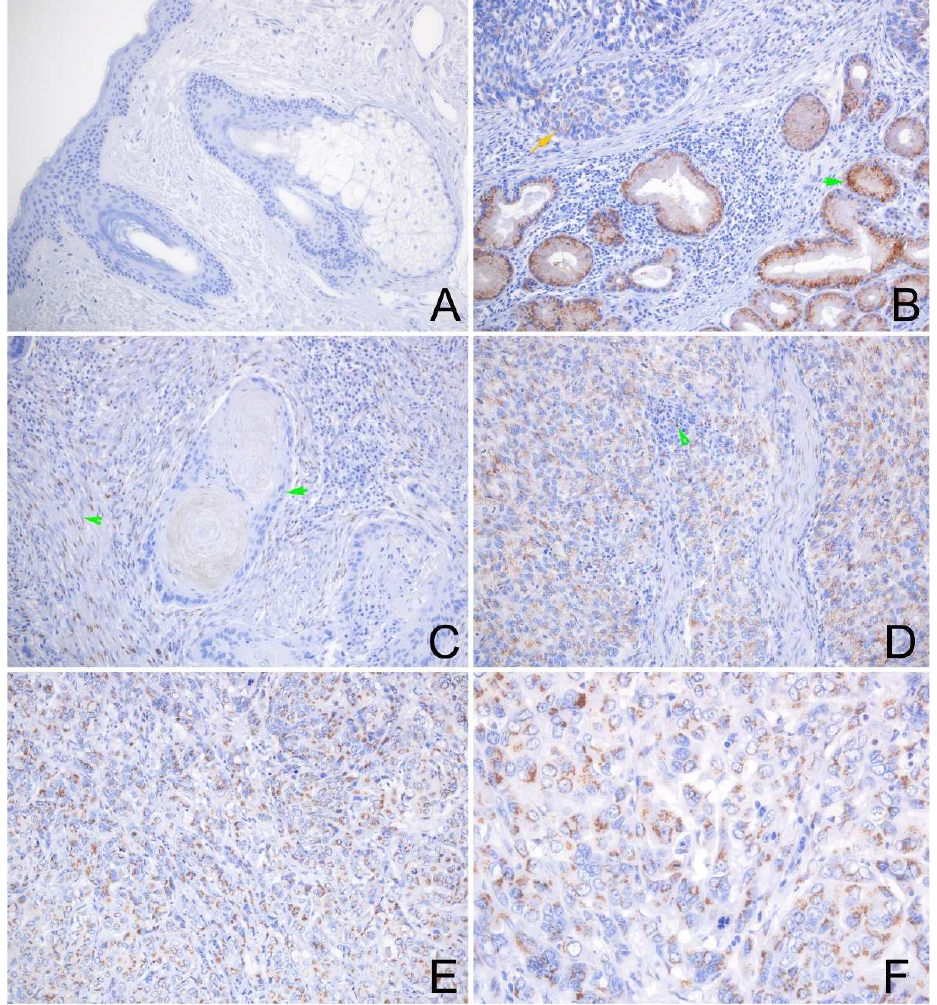
Figure 4. Representative photomicrographs of GOLM1 expression in the normal oral epithelium and HNSCC tissues. ( A ) Shows negative expression of GOLM1 protein in the normal oral squamous epithelium, hair follicle, and sebaceous glands. ( B ) Shows strong positive staining of GOLM1 protein in the normal gland (green arrow), and weak staining of GOLM1 in the SCC (orange arrow). ( C ) Shows negative staining of GOLM1 protein in the well-differentiated SCC, and positive staining of GOLM1 protein in the fibroblast cells. ( D ) Shows positive staining of GOLM1 protein in the tumor cells of moderately differentiated SCC and immune cells (green arrowhead); ( E , F ) Shows positive staining of GOLM1 protein in the tumor cells of poorly differentiated SCC. ( A – E , original magnification ×200; F, original magnification ×400).